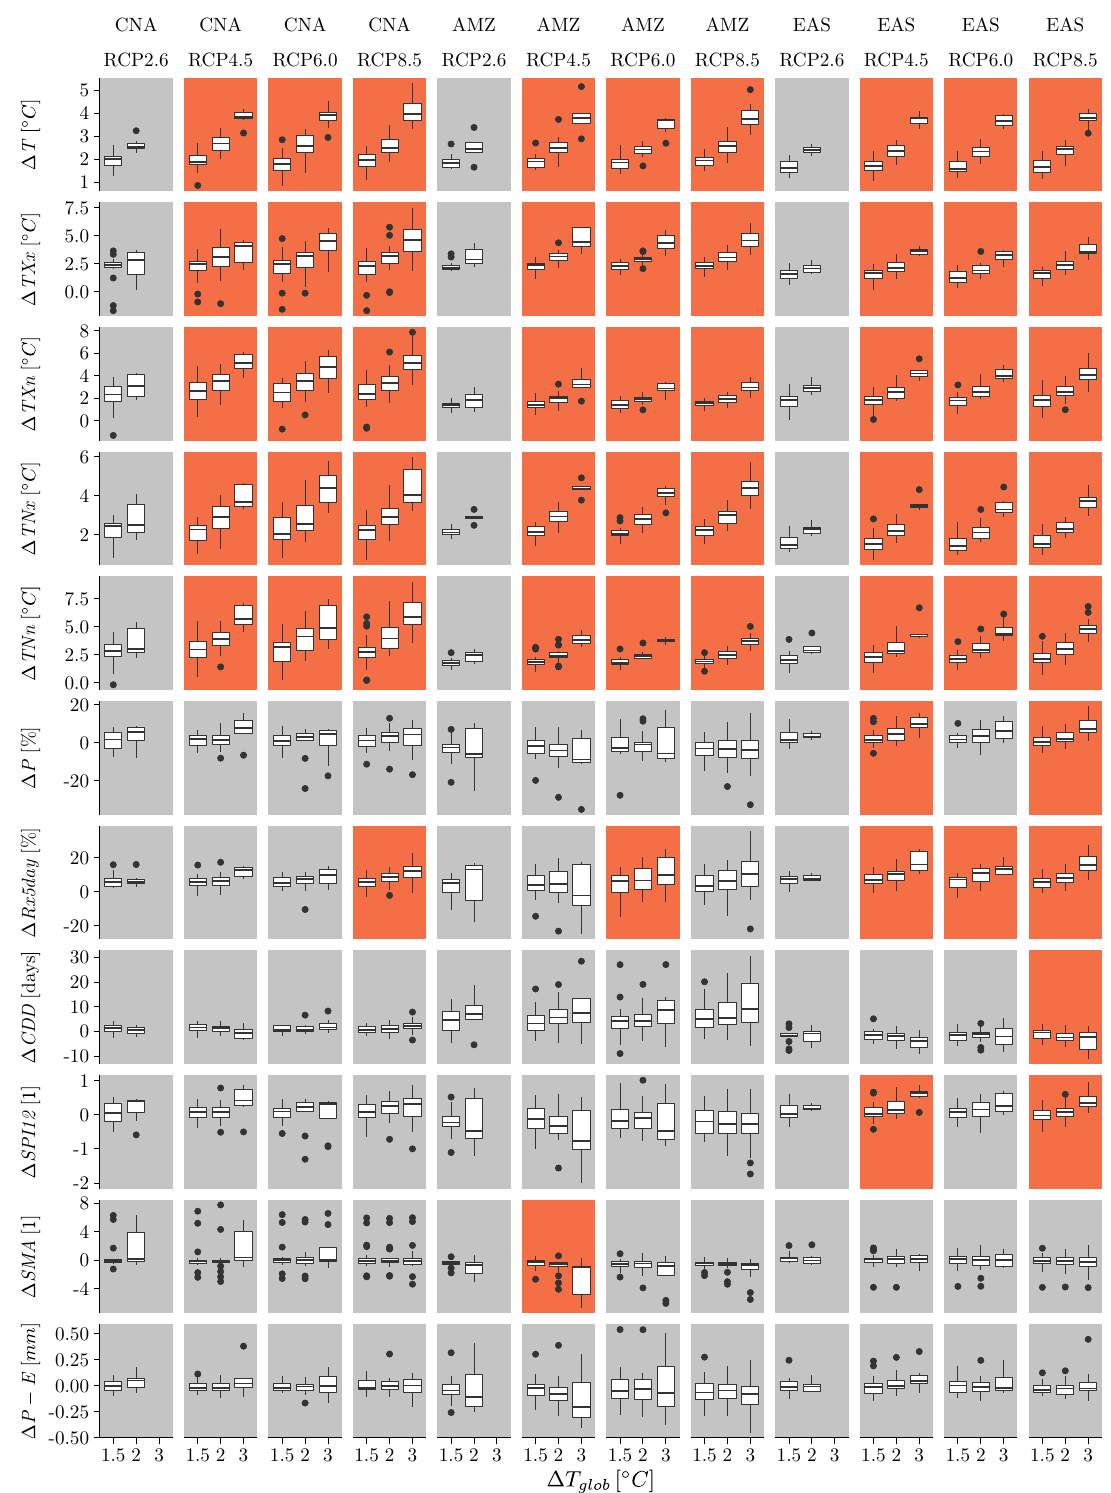
Figure 6. Like Fig. 5 but for SREX regions CNA, AMZ, and